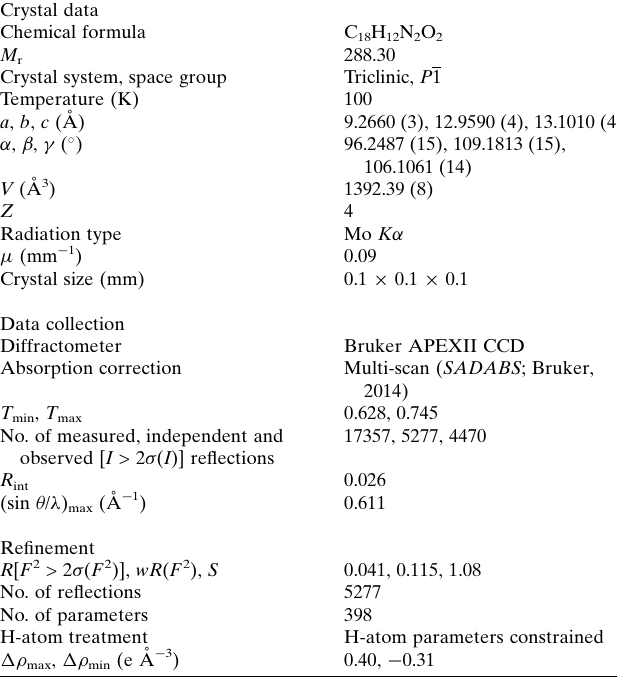
Table 2 Experimental details. Crystal data Chemical